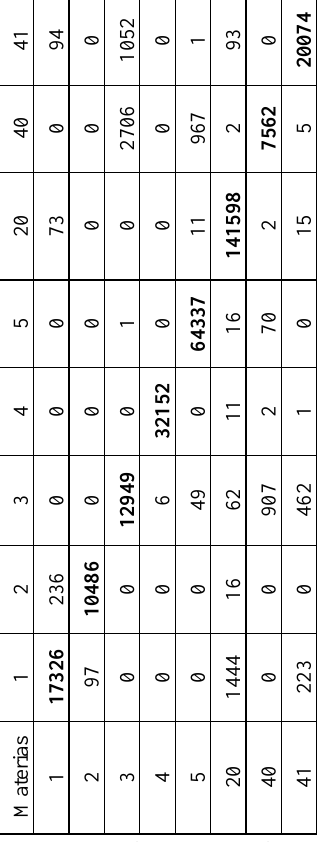
Table 3. Confusion matrix of lineal kernel function, calculated on the rectified image of 2016 (2,5cm/px) Source: Authors,